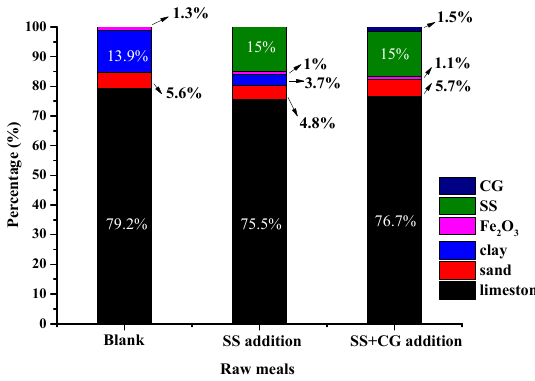
Figure 8. The impact on raw meals compositions with SS or the blend of SS and CG addition.